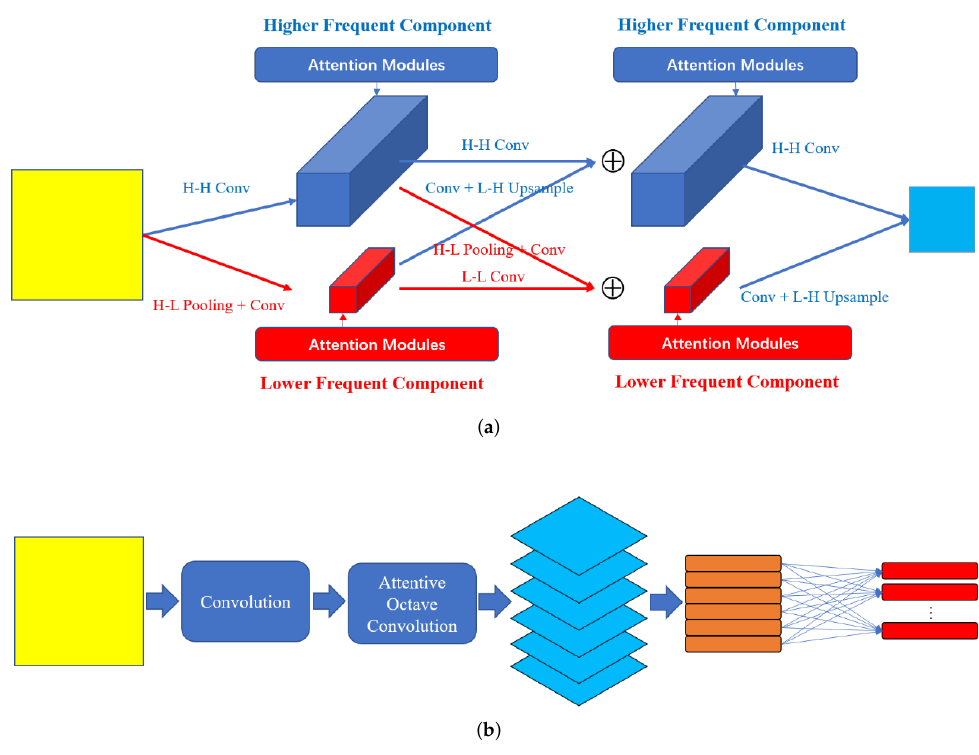
Figure 1. Attentive octave convolution capsule network. ( a ) Attentive octave convolution layer. ( b ) Main framework of